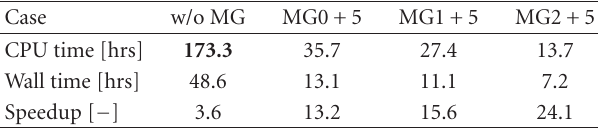
Table 3: Computational time of two-zone MG model with di ff erent combination of searching levels (CA = − 6 . 3 to